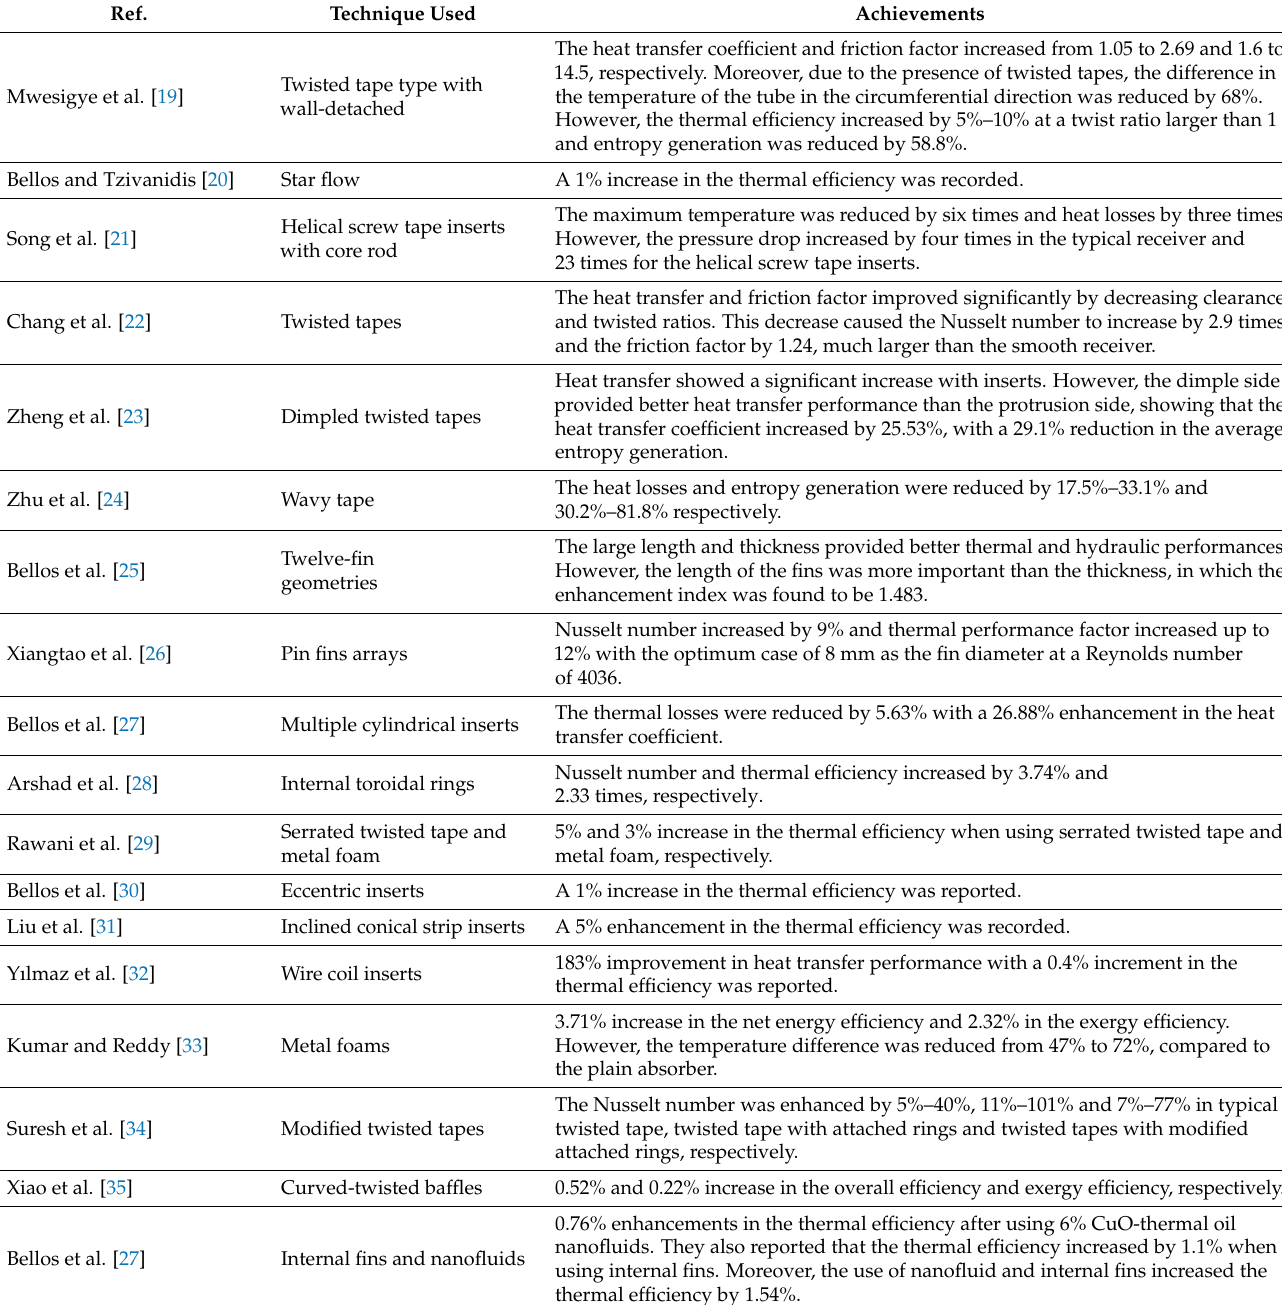
Table 1. Notable studies on the effects of different insert shapes in the